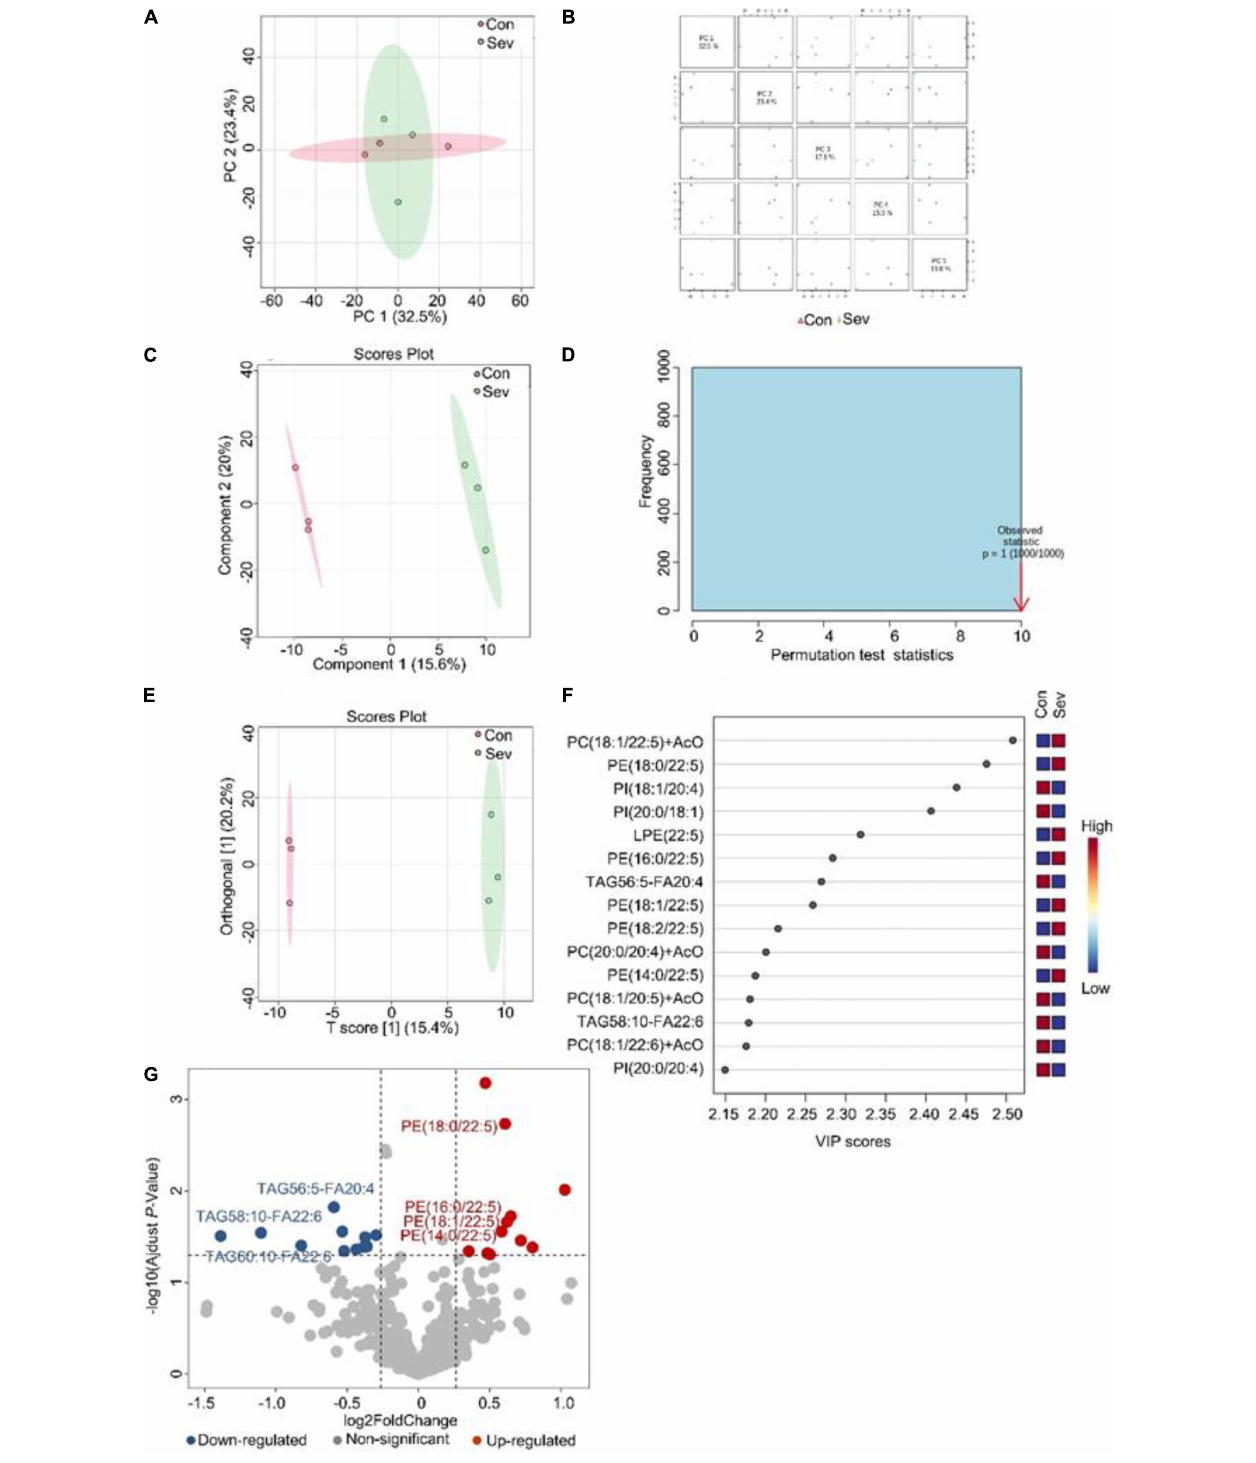
FIGURE 1 | Analysis of lipidomics in the prefrontal cortex of aged marmosets. (A) Two-dimensional score diagram of PCA analysis of sevoflurane anesthesia group and control group in prefrontal cortex of aged marmosets. (B) Pairwise score chart of the top five principal components of PCA. (C) PLS-DA 2D score chart. (D) Permutation test results of PLS-DA Model 1000 times. (E) OPLS-DA 2D score chart. (F) The top 15 lipids ranked by VIP value of the OPLD-DA model. (G) In volcano analysis, red dots indicated the lipid components significantly increased in the sevoflurane group compared with the control group (fold-change > 1.2, P < 0.05); blue dots indicated obviously lower lipid components in the sevoflurane group (fold-change < 0.83, P < 0.05).